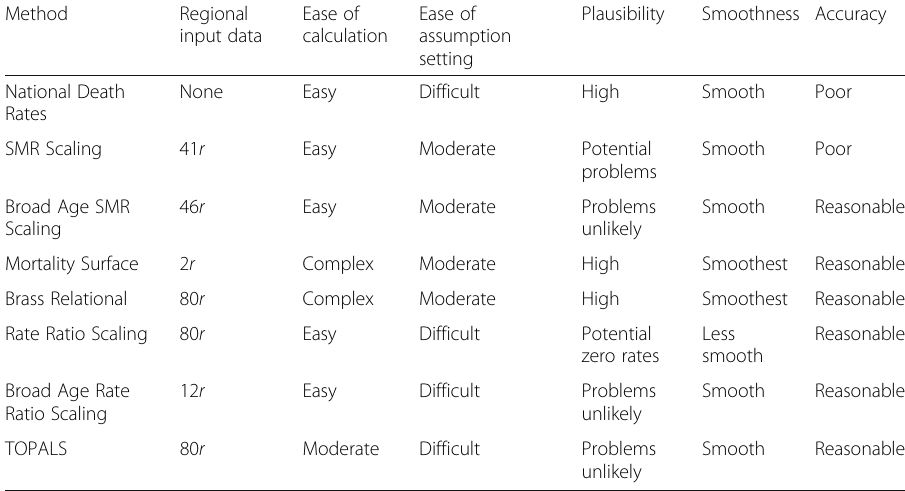
Table 6 Summary evaluation of the mortality forecasting methods applied to Australian regions